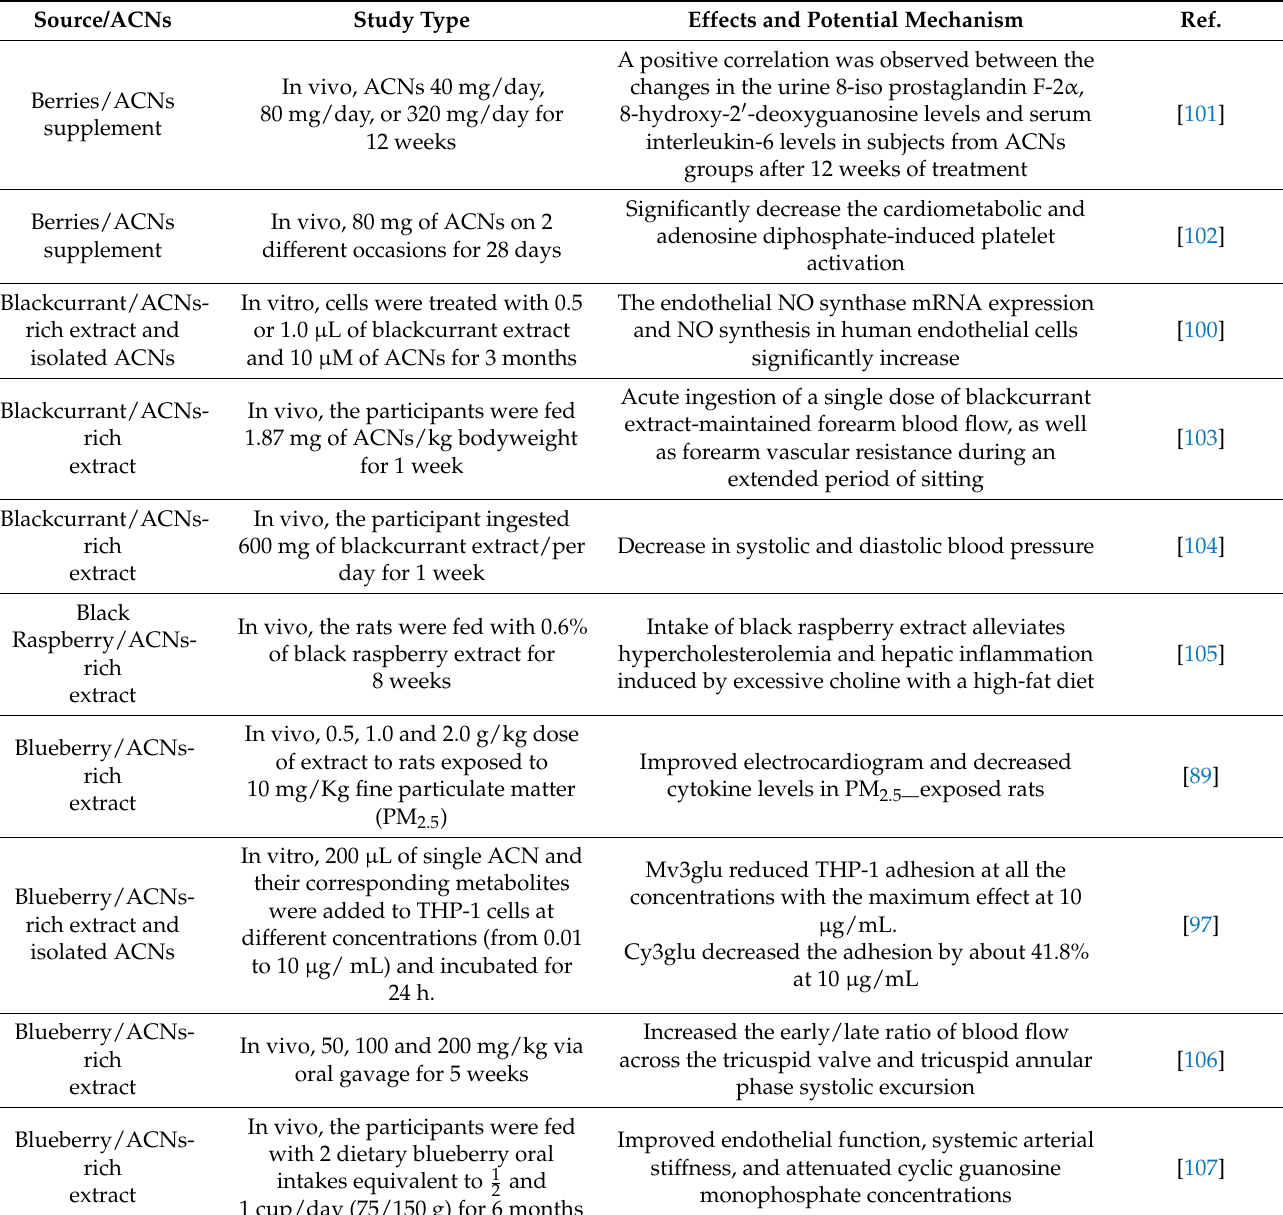
Table 2. The effects of anthocyanins in